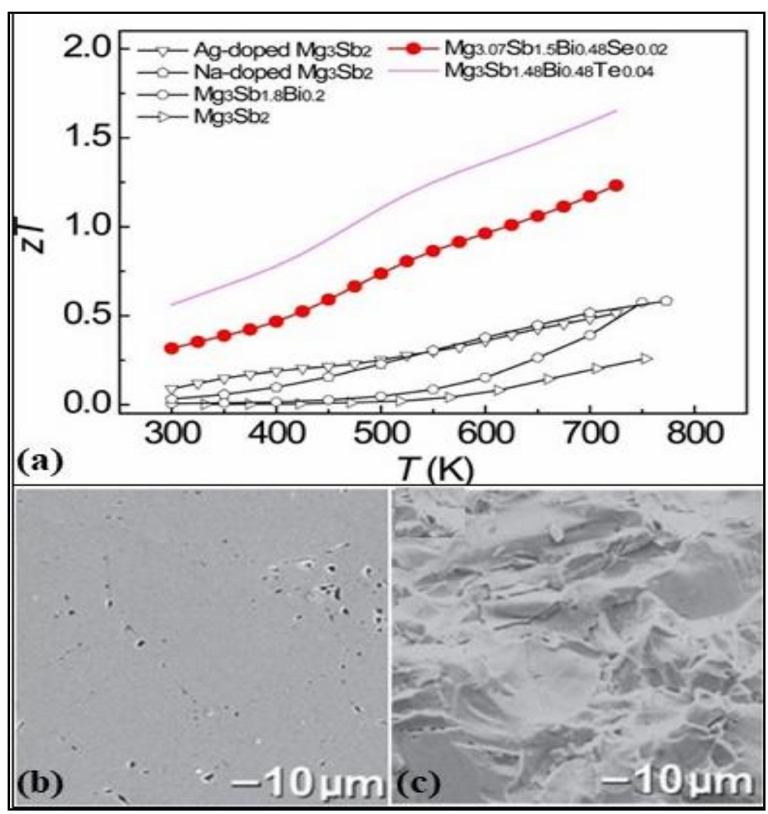
Figure 8. ( a ) Temperature dependence of figure of merit for various Mg 3 Sb 2 -based Zintl com- pounds: Silver doped Mg 3 Sb 2 , sodium doped Mg 3 Sb 2 , Mg 3.07 Sb 1.5 Bi 0.48 Se 0.02 , Mg 3 Sb 1.48 Bi 0.48 Te 0.04